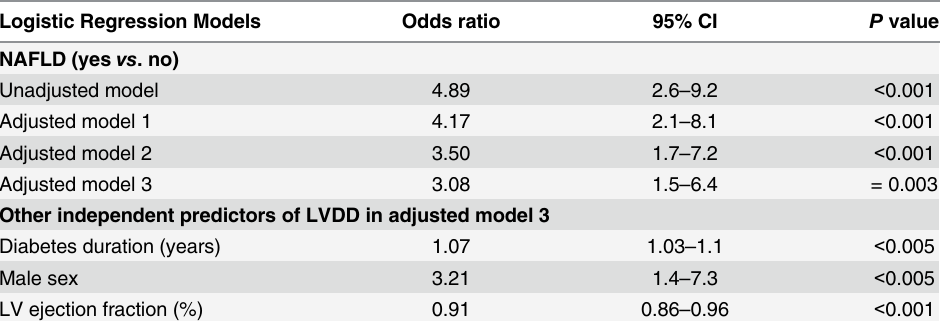
Table 3. Independent predictors of the presence of mild and/or moderate LV diastolic dysfunction in patients with type 2 diabetes. Logistic Regression Models Odds ratio 95% CI P value NAFLD (yes vs . no) Unadjusted model 4.89 2.6 – 9.2 < 0.001 Adjusted model 1 4.17 2.1 – 8.1 < 0.001 Adjusted model 2 3.50 Adjusted model